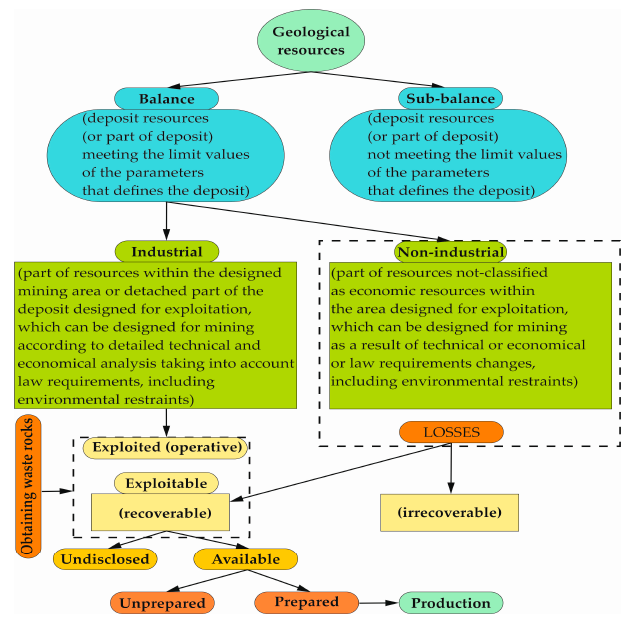
Figure 3. Division of geological resources .